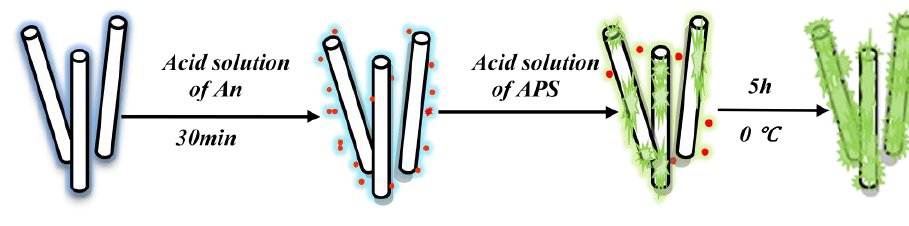
Figure 1. Fabrication of PANI/PA6 composite